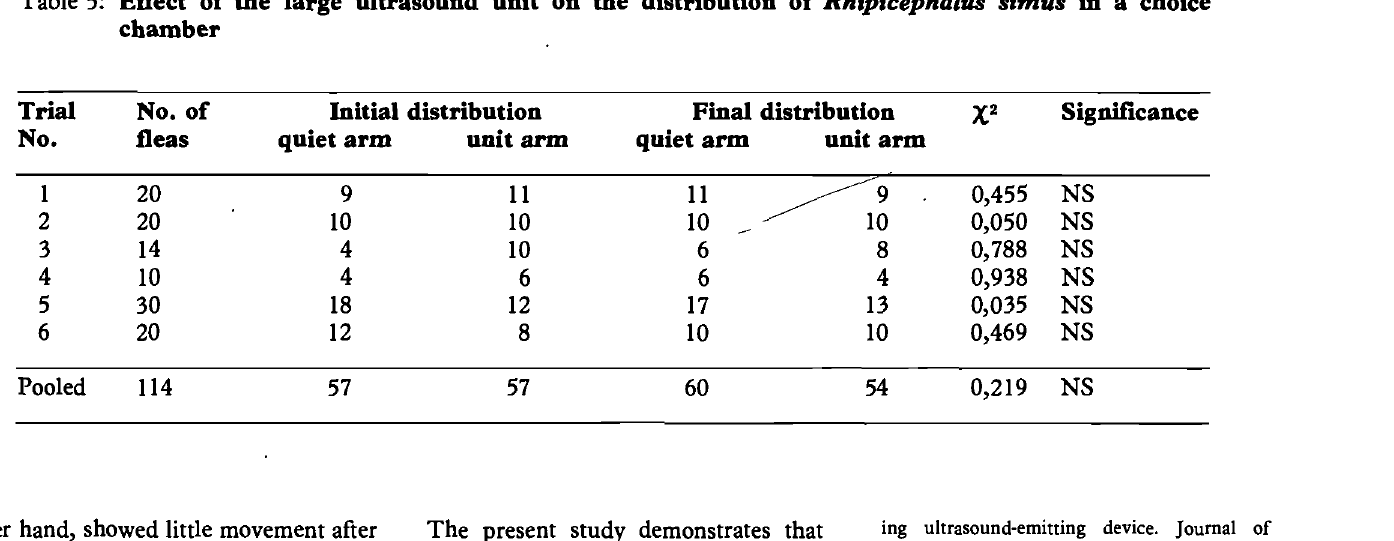
Table 5: Effect of the large ultrasound unit on the distribution of Rhipicephalus simus in a choice